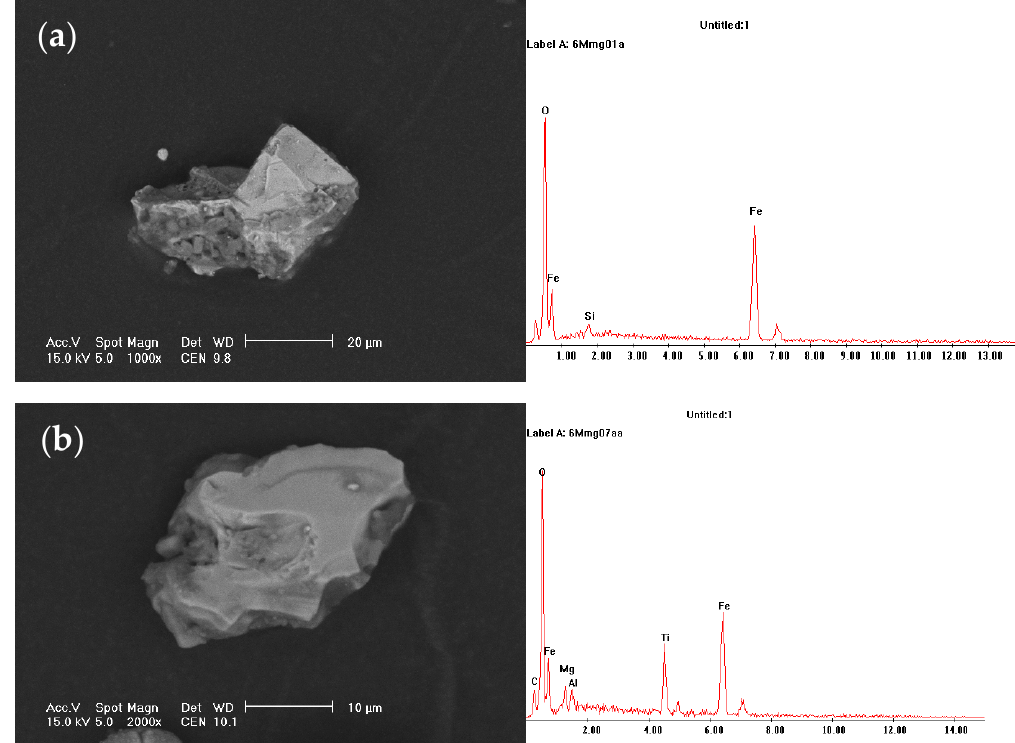
Figure 2. Iron oxide with a structure similar to maghemite ( a ) and ( b ) iron oxide with an admixture of titanium, magnesium and aluminum, present in fly ash after lignite combustion.